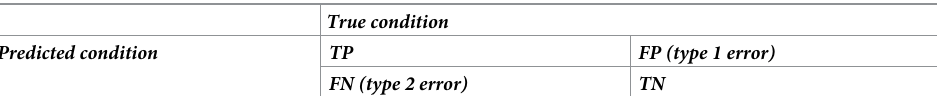
Table 7. Confusion